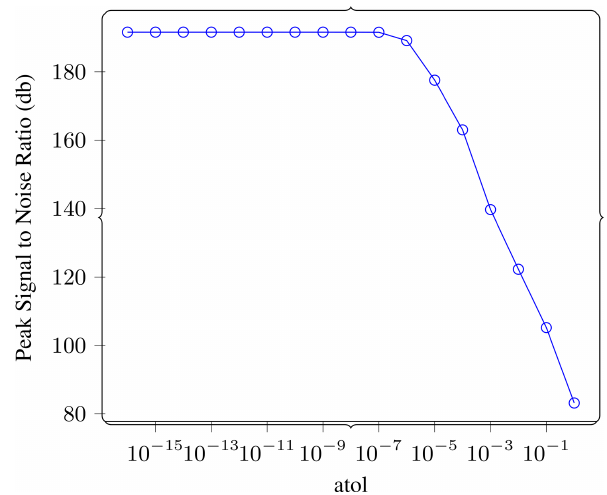
Figure 8. Forward propagation. We stop the simulation after about 500 time steps. We then compress the state of the wave field at this point using atol = 10 − 6 . We then continue the simulation from the lossy checkpoint and compare it with the reference version. Here we show the error as PSNR. In these plots, higher is better, whereas lower implies more error. The PSNR dropped slightly over the first few time steps and then remains essentially constant after.